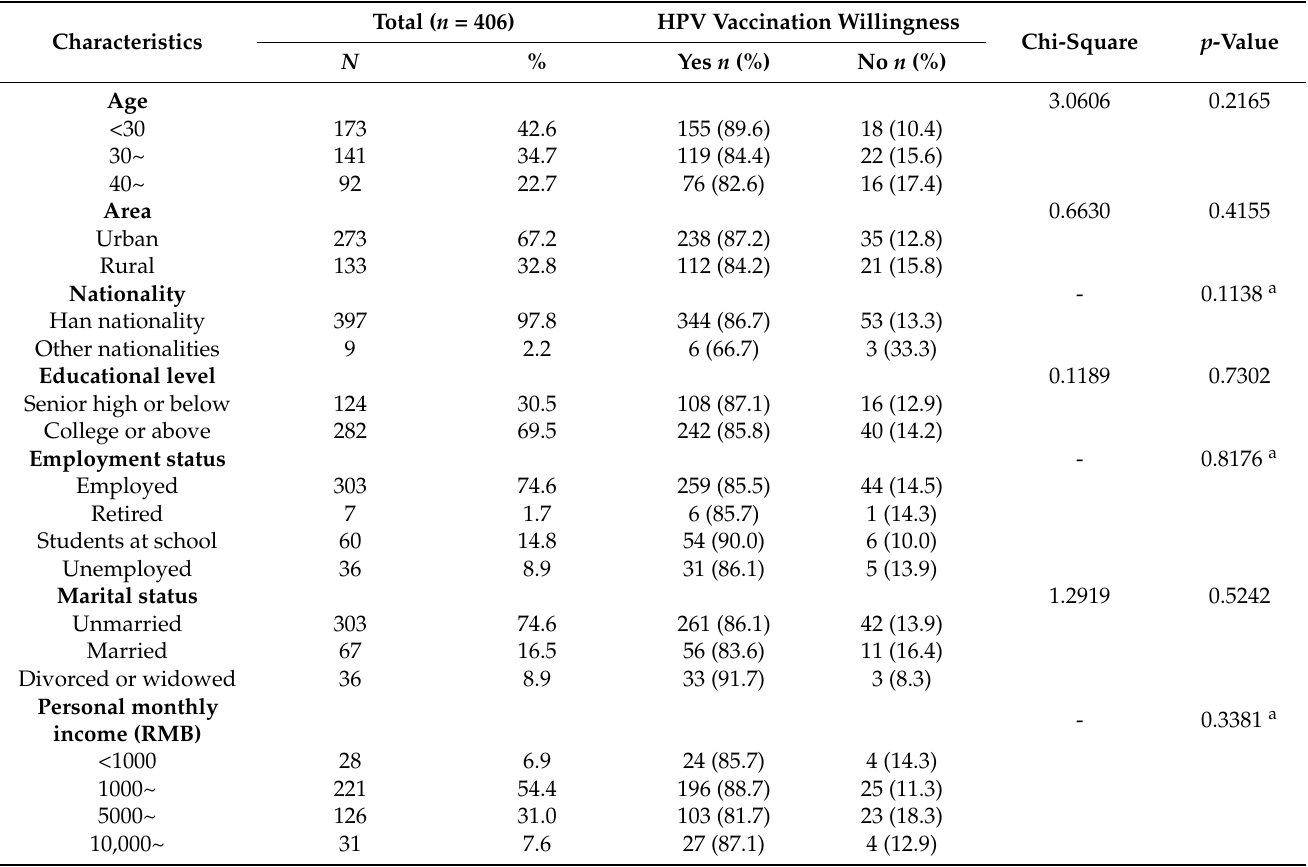
Table 1. Relationship between demographic characteristics and HPV vaccination